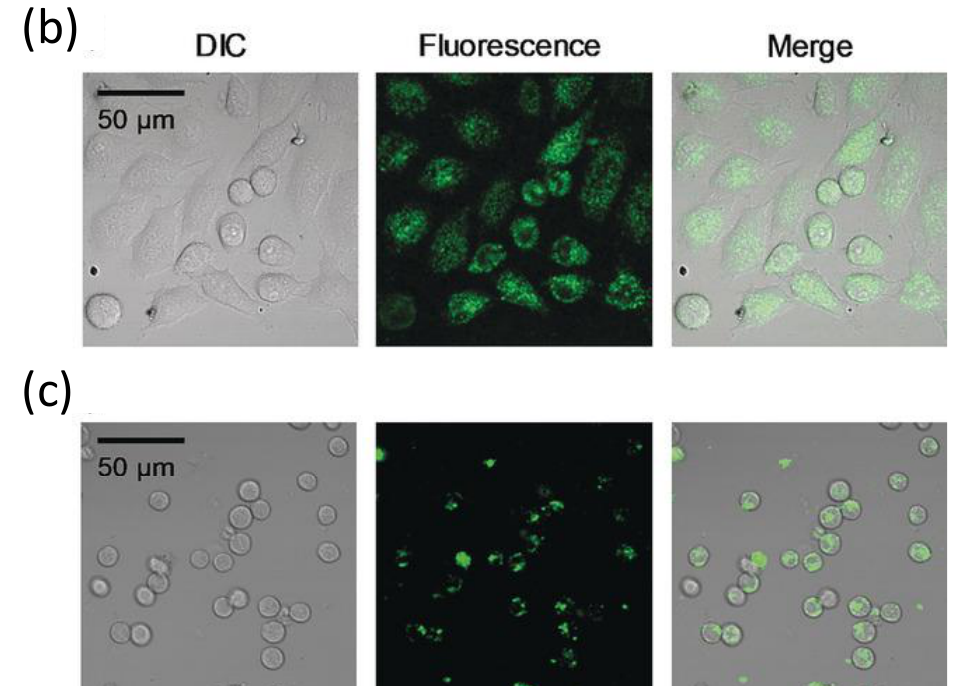
Figure 9. ( a ) Chemical structure of the CFNT. At lower temperatures, the CFNT swells by absorbing water into its interior, where the environment-sensitive DBThD-AA units are quenched by neighboring water molecules. When heated, CFNT shrinks with the release of water molecules, resulting in fluorescence from the DBThD-AA units. ( b ) Differential interference contrast (DIC) image, confocal fluorescence image, and merged image of HeLa cells treated with 1 (0.05 w/v%), and ( c ) DIC image, confocal fluorescence image, and merged image of MOLT-4 cells treated with the CFNT (0.05 w/v%). Reproduced with permission from reference [87]. Copyright 2018, John Wiley and Sons.